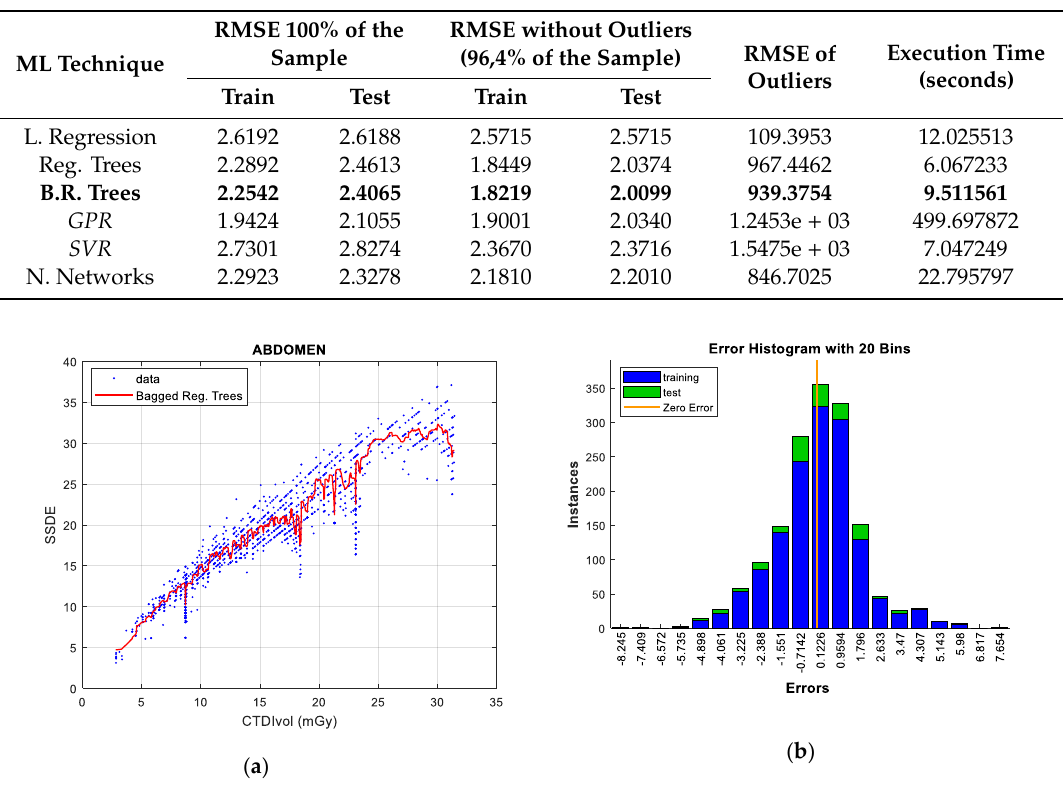
Figure 13. SSDE prediction according to CTDI VOL for Thorax protocol ( left ), together with error histograms ( right ), employing the Neural Networks technique ( a , b ). Table 18. SSDE-CTDI VOL results for Abdomen protocol.